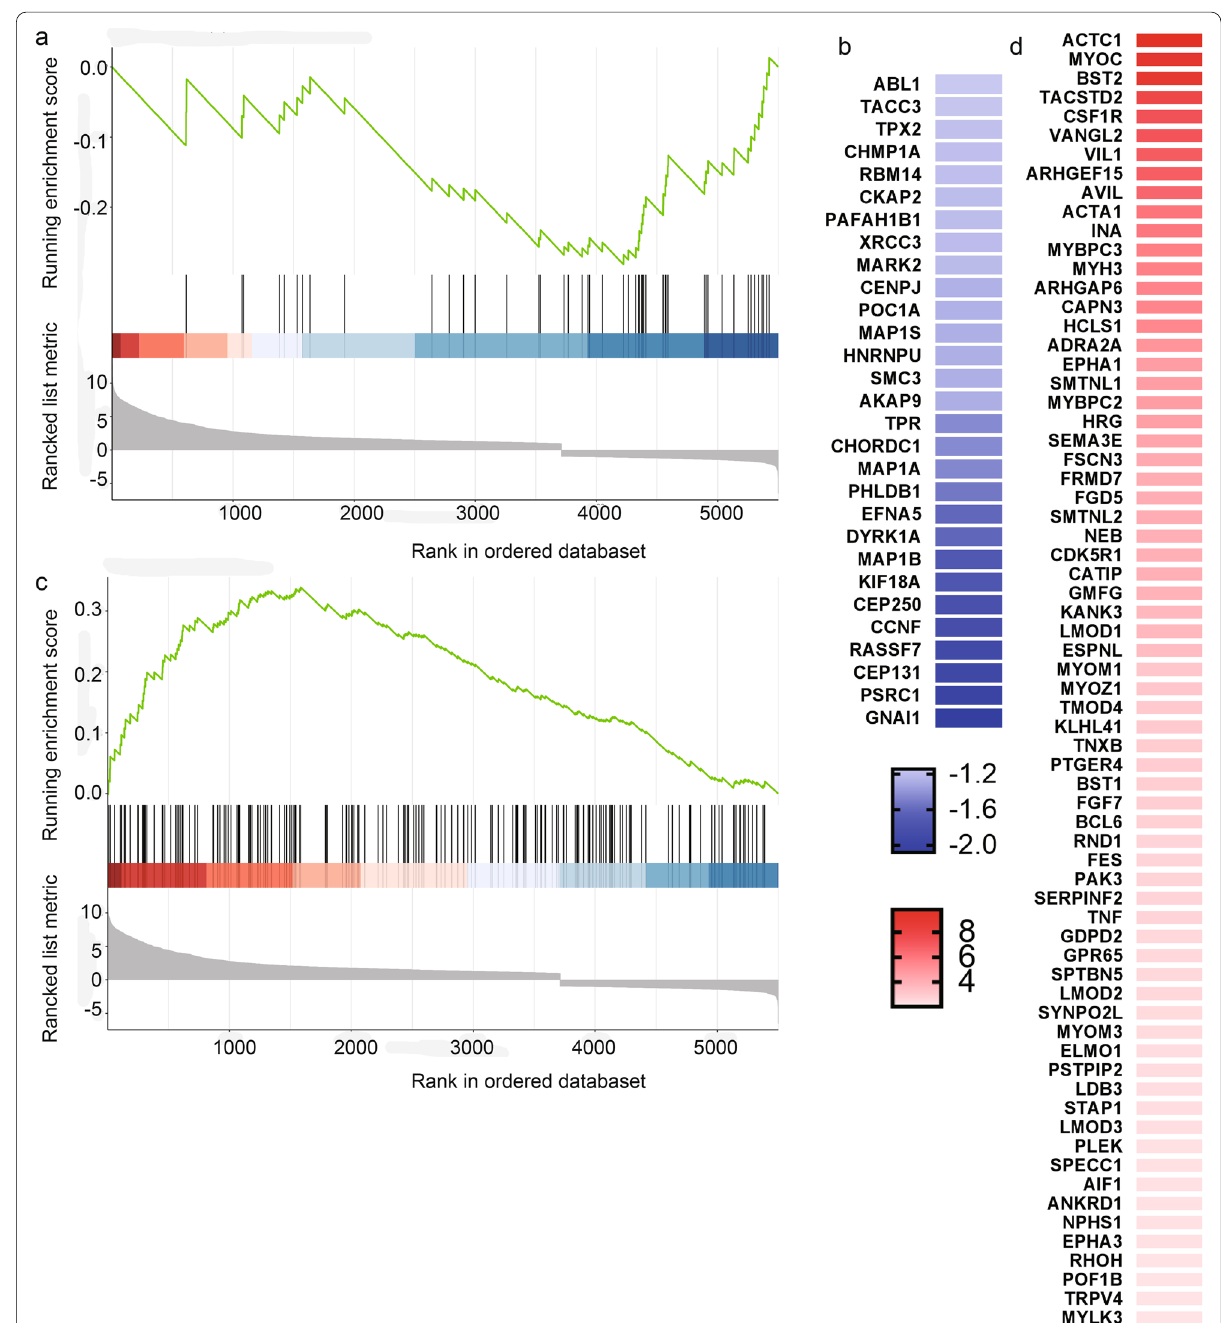
Fig. 5 GSEA plots for enriched genes regulating the cytoskeleton structure. a GSEA plot indicating the negative running enrichment score for the “regulation of microtubule cytoskeleton organization” (NES -2.3, padj 0.01) ( b ) with a number of the down-regulated genes participating = = in the process displayed in the form of a heatmap. c GSEA plot showing the positive running enrichment score activating the “actin cytoskeleton organization” (NES 1.31, padj 0.02) ( d ) with a list of the top activated genes shown in a heatmap. Black bars underneath the graph present the = = rank positions of genes from the gene set. The green line refers to the enrichment profile. GSEA, gene set enrichment